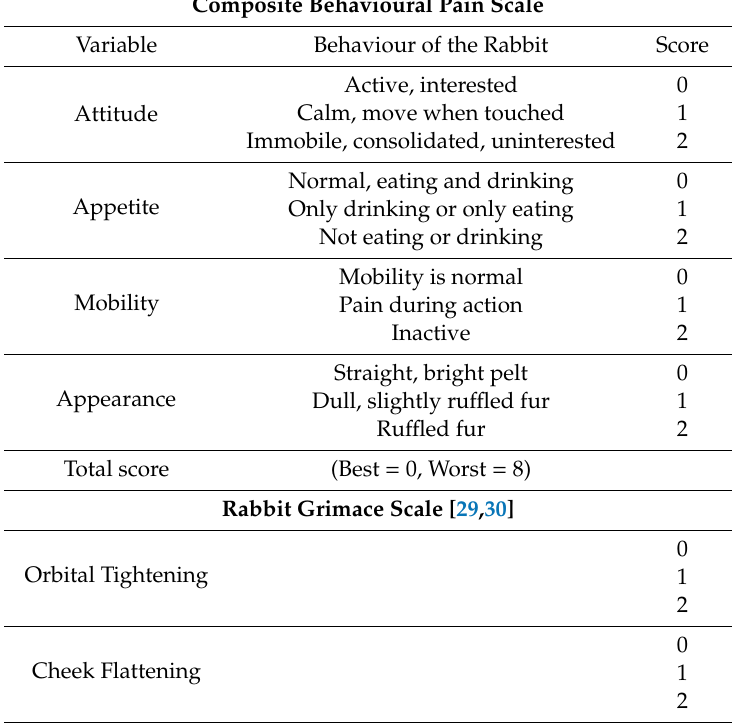
Table 2. Composite behavioural pain scale and rabbit grimace scale [30,31] used by one of three trained operators to assess pain in 14 rabbits undergoing surgical creation of critical-sized defects in the calvarial bone at baseline, on the day of surgery and for 3 days after intervention at 06:00 am, 10:00 am, 14:00, 18:00 and